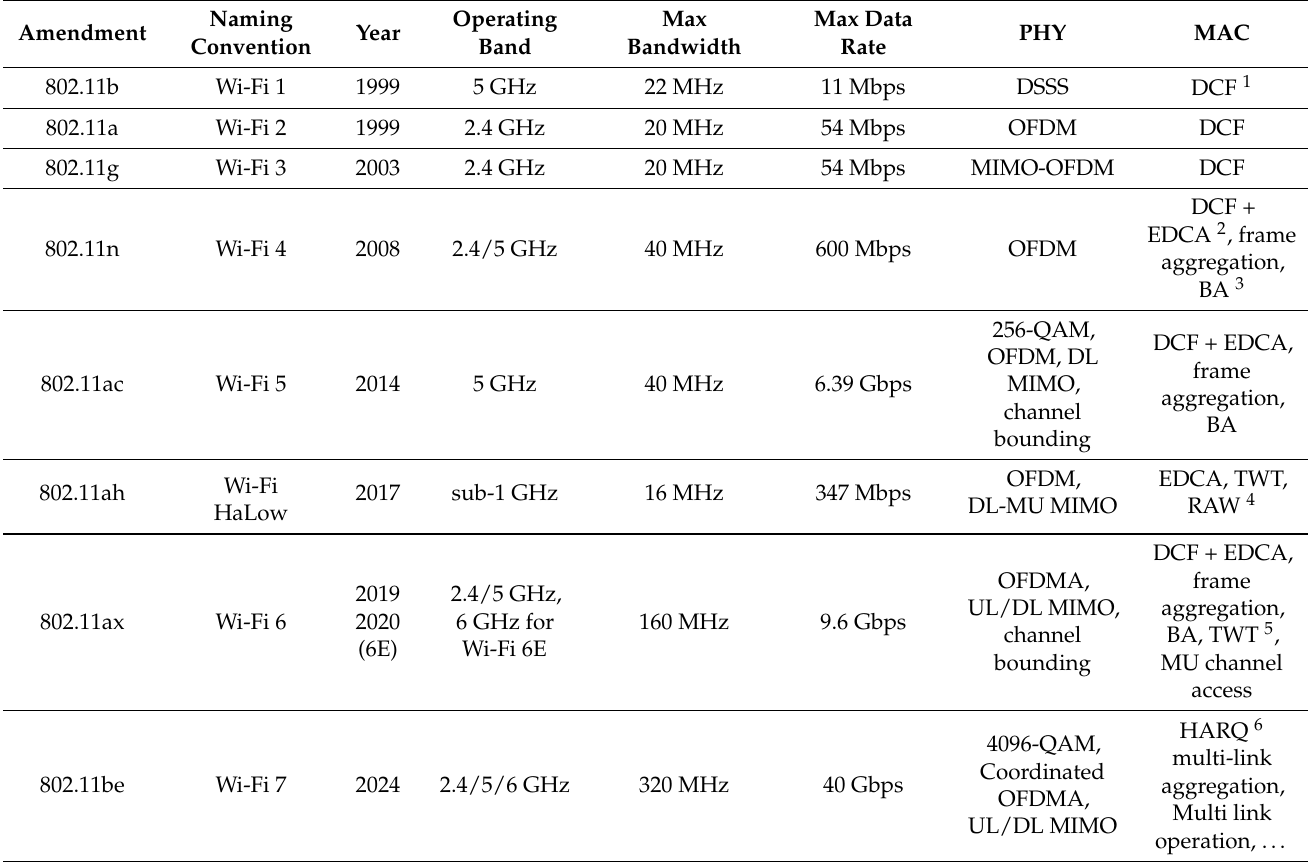
Table 2. Summary of the different features of 802.11 family amendments.